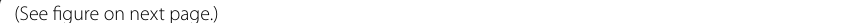
nephron(See figure on next Fig. 5 a–l Sketches almost true to scale illustrate the interstitial situation at the developing nephron in the fetal human kidney during advanced pregnancy. Depicted are the configuration of the interstitium at the a pretubular aggregate (PTA), the b site of the mesenchymal-to-epithelial transition, and the c primitive renal vesicle (RV). Inserts, C renal capsule, SP stromal progenitor cells, NP nephrogenic progenitor cells, DE distal end, PE proximal end, PTA pretubular aggregate, PRA/black arrow perforating radiate artery, black asterisks interface, white asterisk adhesion, CNT connecting tubule of a previously developed nephron, A collecting duct (CD) ampulla, T tip, H head, CO conus, N neck, flash partial separation of RV from PTA, lumen, C renal capsule, NZ nephrogenic zone, MZ maturation zone. Demonstrated is further the extension of the interstitium at + the d mature, e extending, and f extended renal vesicles (RV). DP distal pole, PP proximal pole, TA tubule anlage with the future connecting tubule (CNT) of the presently developing nephron, arrow head progenitor cell strand between RV and PTA. Shown is also the interstitial configuration at the g early, h mid, and ( i ) late comma-shaped bodies (CSB). DT distal tubule, IT intermediate tubule, PT proximal tubule, P future podocytes, BC presumptive Bowman’s capsule. Finally, depicted is the extension of the interstitium at the j early, k mid, and l late S-shaped bodies (SSB) including the defoliation of the glomerulus at the proximal pole and the physiological connection of the CNT with the CD ampulla. Light blue/zigzag, interstitium within the renal capsule. Dark blue/vertical double arrow, interstitium between the inner side of the renal capsule and the tip of a CD ampulla. Yellow line with crosses, subcapsular interstitium. White boxes with red line, perivascular interstitium at the perforating radiate artery. Black line, peritubular interstitium at the connecting tubule. White boxes with red line and arrowhead, interstitial cleft at the deep lateral aspect between the tubule anlage and the defoliating glomerulus during formation of the comma- and S-shaped bodies. Dashed black line, oblique interstitial cleft between the tubule anlage and the progenitor cell strand, which connects the distal pole of the renal vesicles with the proximal end of the pretubular aggregate. White arrow, vertical narrow interstitial cleft between the CD ampulla and the medial aspect of the shaping